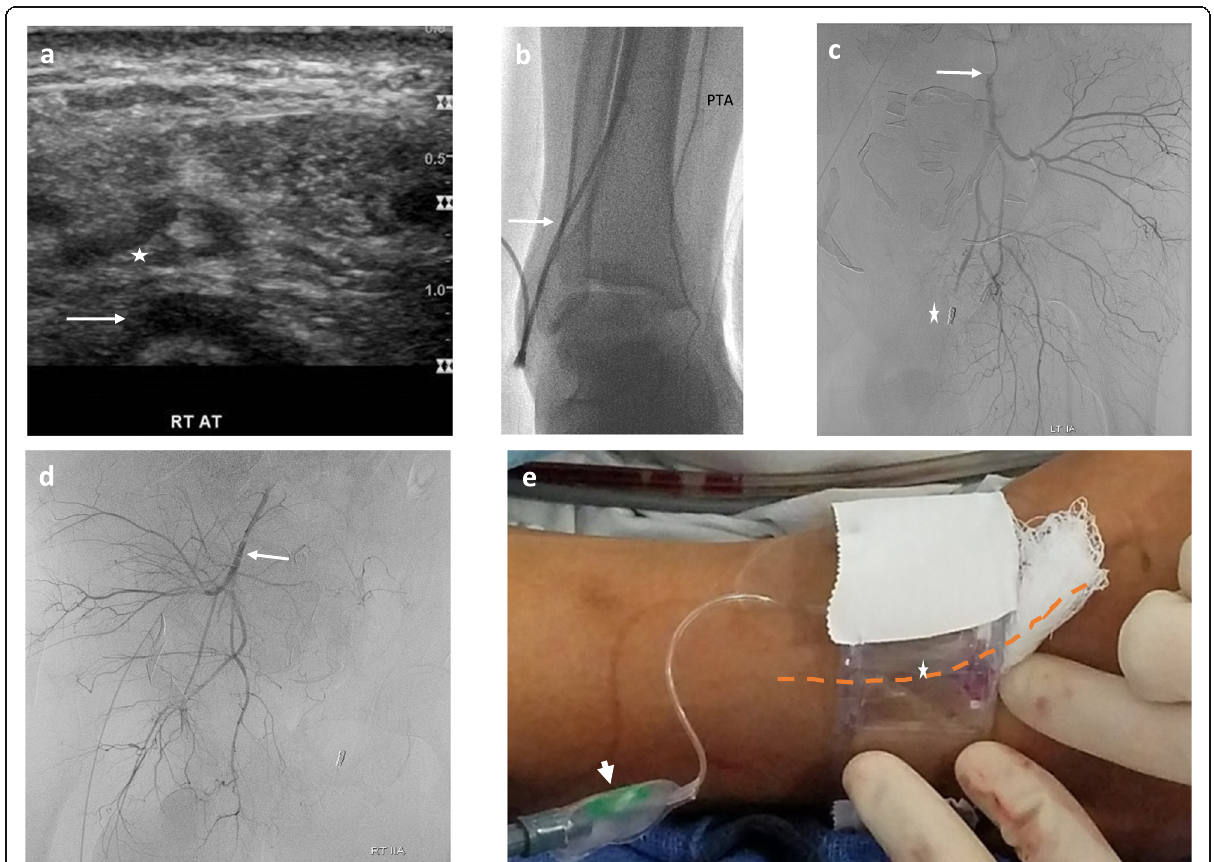
Fig. 2 Patient 1 Subsequent angioembolization procedure via a trans-tibial approach: Ultrasound guided access into the distal right ATA (*) over the distal tibial cortex (arrow). Hand injection through vascular sheath following ATA access (arrow) showing reflux into the PTA ( b ). Left internal iliac angiogram via base 0.035 catheter (arrow) demonstrates occluded left pudendal artery (*), and no signs of hemorrhage in the left hemi- pelvis ( c ). Right internal iliac angiogram via base 0.035 catheter (arrow) was negative for hemorrhage ( d ). Hemostasis of the ATA ( − − - indicates underlying arterial course) was achieved with a large TR band (* indicates balloon; arrowhead points to inflation port) buttressed by a